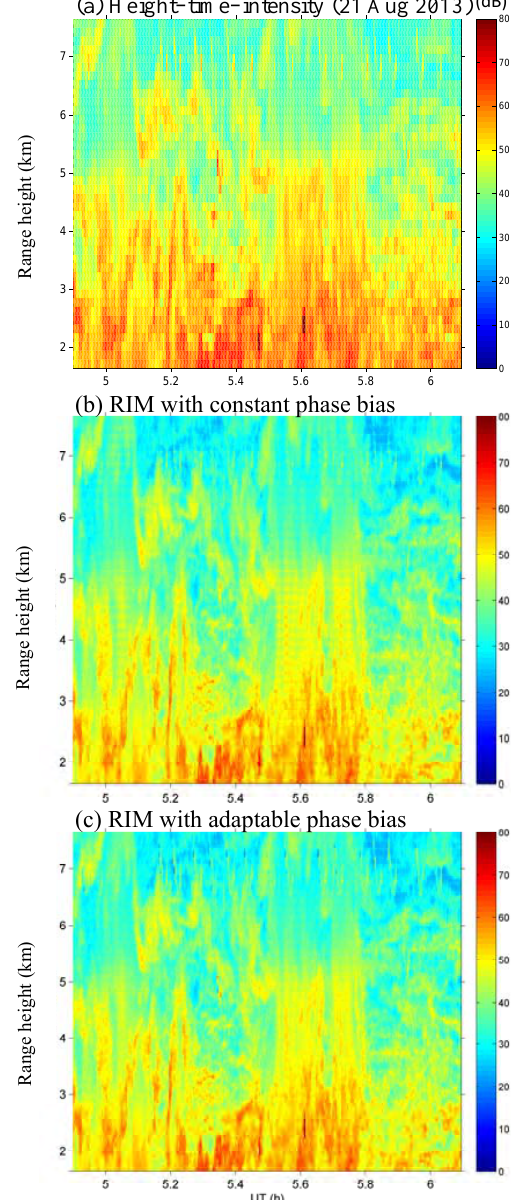
Figure 5. (upper) Height–time–intensity with a range resolution of Figure 4: (a) High-time intensity with a range resolution of 150 m, and (b, c) 150m, and (middle and bottom) RIM-produced brightness with, re- spectively, constant and adaptive values of range error in the cor- RIM-produced brightness with, respectively, constant and adaptive values of range rection process. Imaging range step is 1m. Data time: 21 August error in the correction process. Imaging range step is 1 m. Data time: 21 August 2013. 2013.